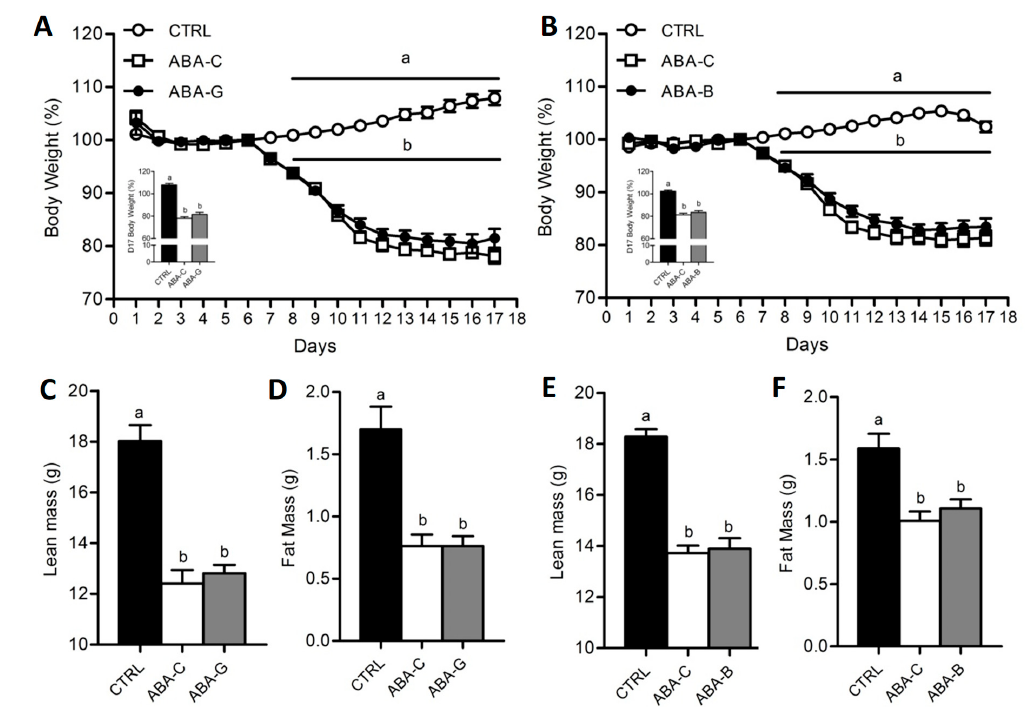
Figure 1. Body weight, lean mass and fat mass. Body weight was monitored each day, expressed in percentage compared to day 6, for both Gln ( A ) and BCAA ( B ) series with control mice (CTRL; open circles), non-supplemented activity-based anorexia mice (ABA-C; open squares, n = 16) and supplemented activity-based anorexia mice (ABA-G or ABA-B; closed squares). Body change at day 17 was measured, expressed in percentage compared to day 6, for both Gln and BCAA. Lean and fat mass, expressed in grams, were measured by using Minispec for both Gln ( C , D ) and BCAA ( E , F ) series. Column bar graphs showed control mice (CTRL; black bars), non-supplemented activity-based anorexia mice (ABA-C; open bars) and supplemented activity-based anorexia mice (ABA-G or ABA- B; grey bars). Values without a common letter significantly differ (p < 0.05). The number of mice was n = 16 for CTRL, n = 16 for ABA-C and n = 12 for ABA-G ( A, C, D ) and n = 16 for CTRL, n = 16 for ABA-C and n = 14 for ABA-B ( B, E, F ).